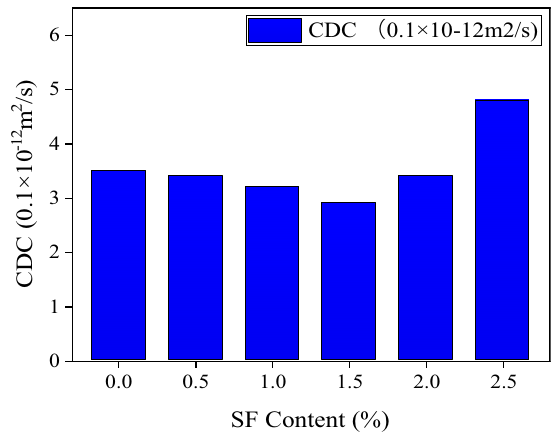
Figure 13: E ff ect of SF content on chloride di ff usion coe ffi cient of concrete mixed with 3%